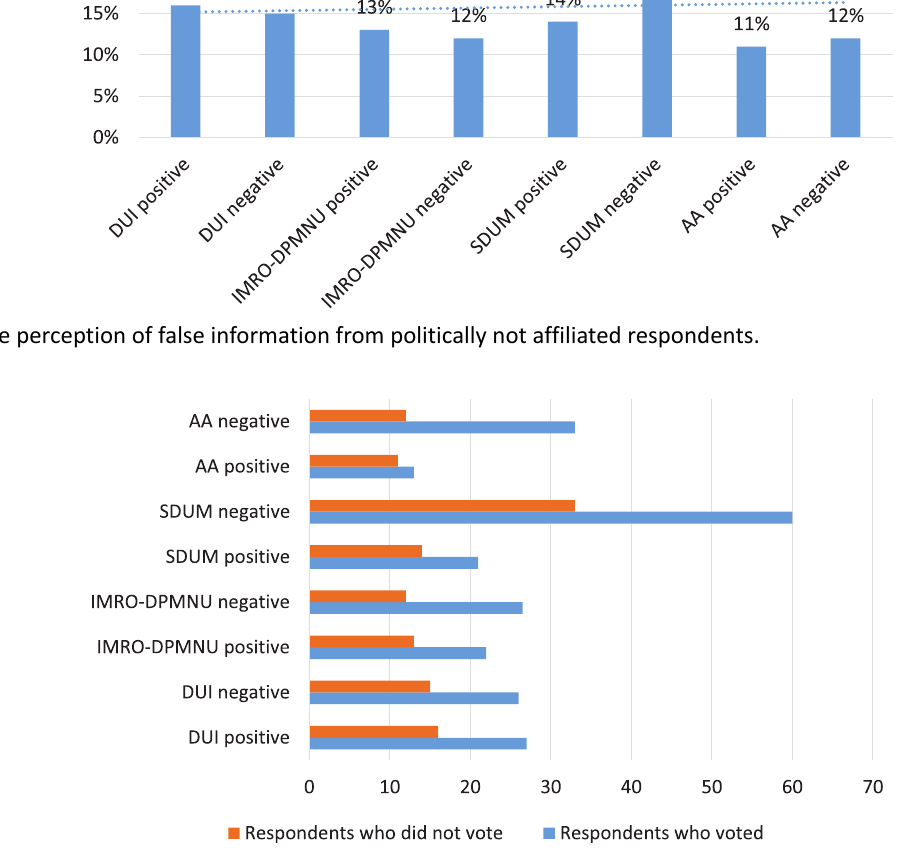
Figure 6. Comparison of vulnerability to disinformation between the politically and non‐politically affiliated